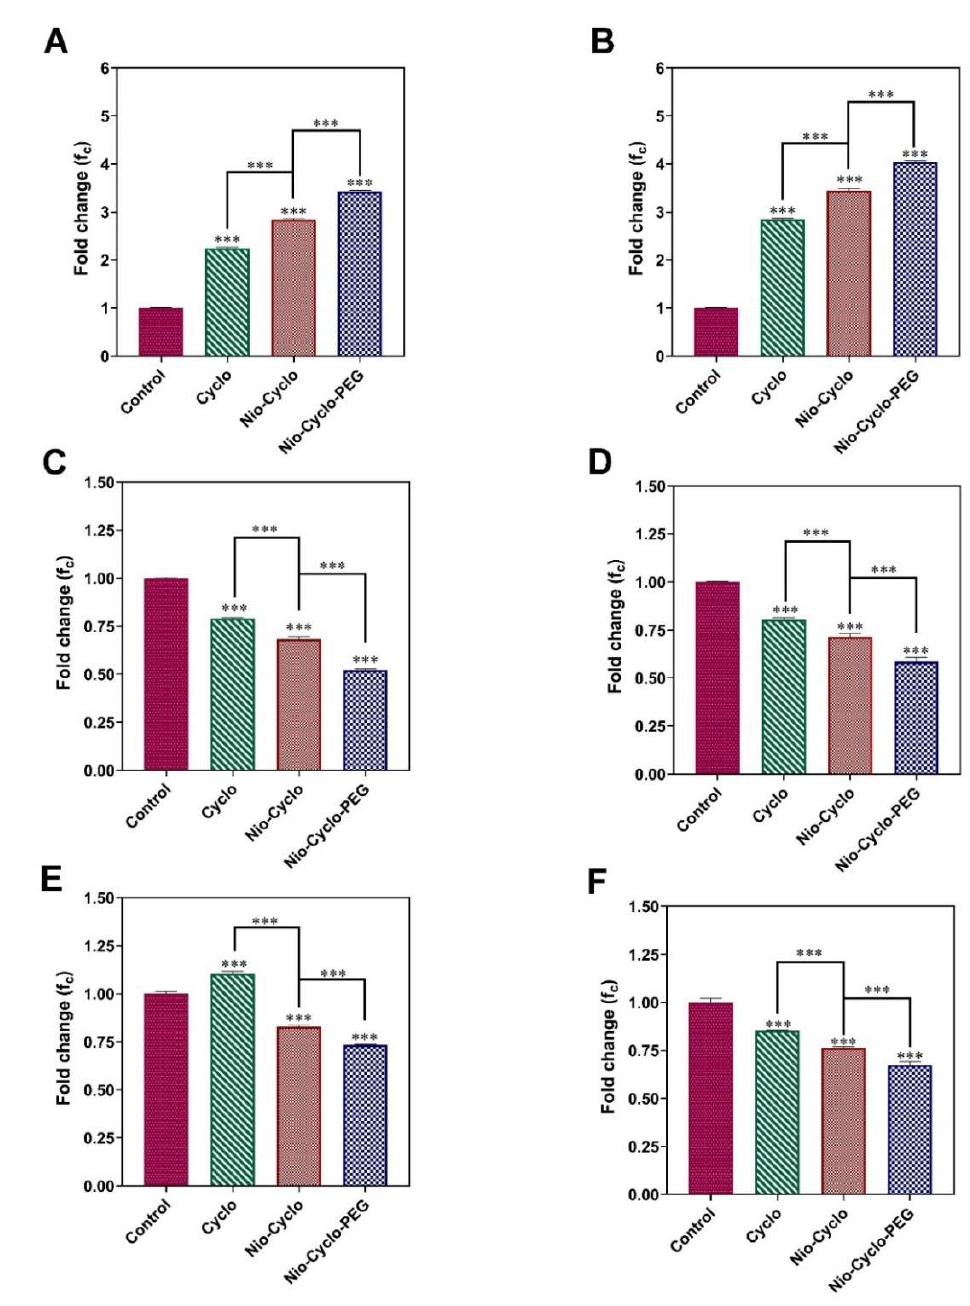
Figure 5. The expression profiles of ( A ) Caspase 3 , ( B ) Caspase 9 , ( C ) Cyclin D , ( D ) Cyclin E , € MMP- 2 , and ( F ) MMP-9 in AGS cells after treatment with different niosomal formulations; Data are represented as Mean ± SD from three independent experiments (***: p < 0.001).